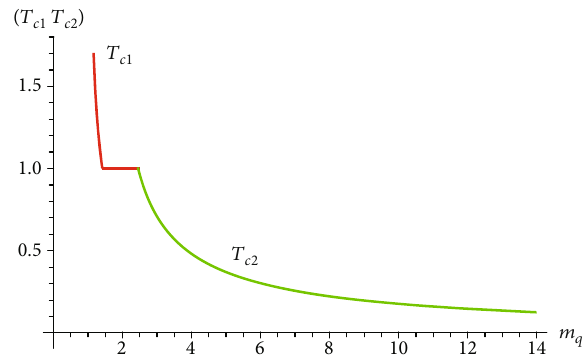
Figure 12: A phase diagram for T